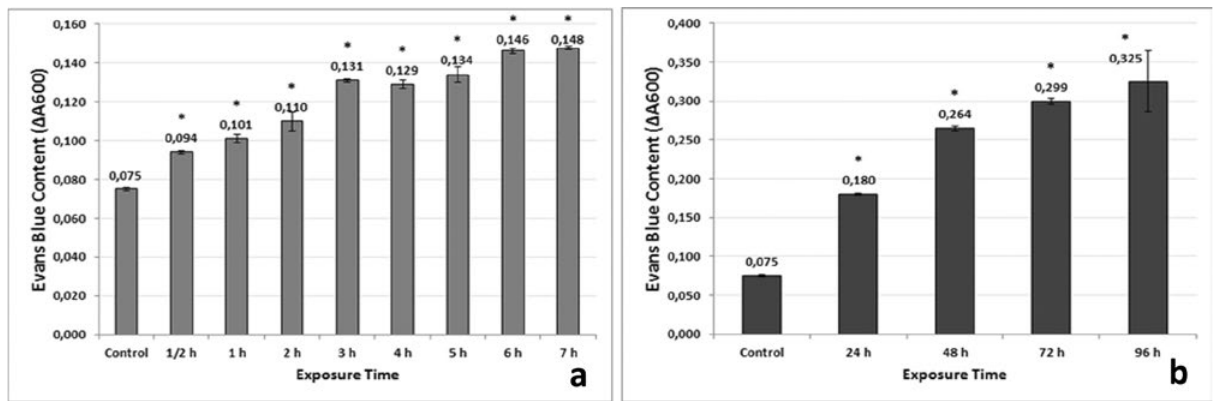
Figure 2. Evans blue uptake of control and 100 µM AlCl 3 treated barley roots at short (a) and long (b) time points. The data with (*) are significantly different from the control at P < 0.05 level.